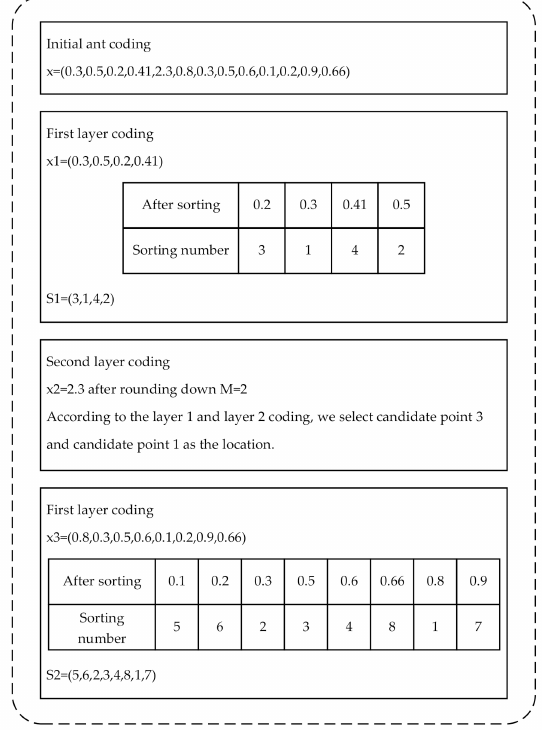
Figure 3. Encoding and decoding example